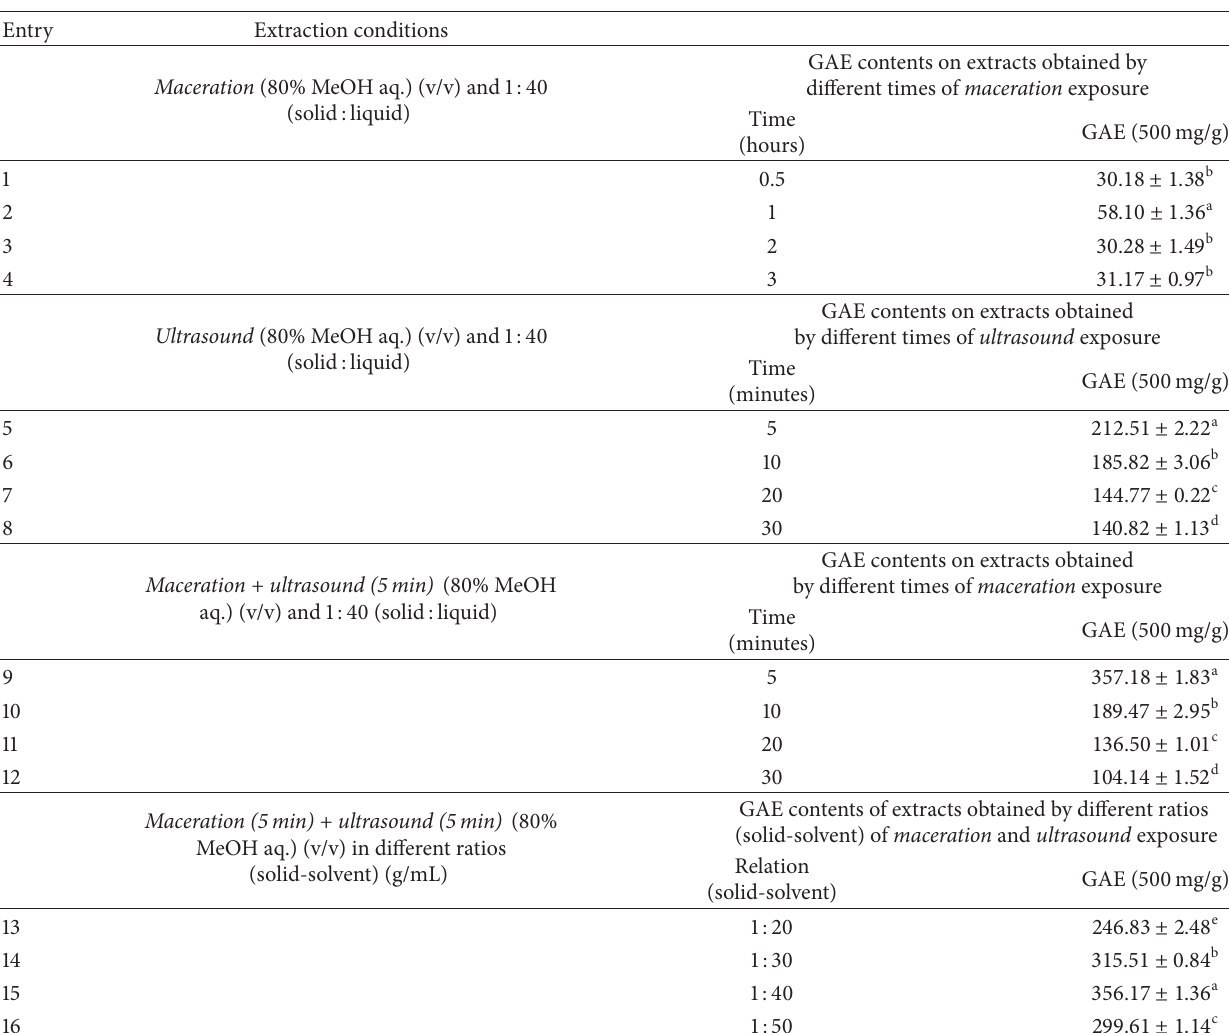
Table 1: Total phenolic compounds contents in GAE proceeding from different extracts obtained from the leaves of A. repens measured by the Folin-Ciocalteu